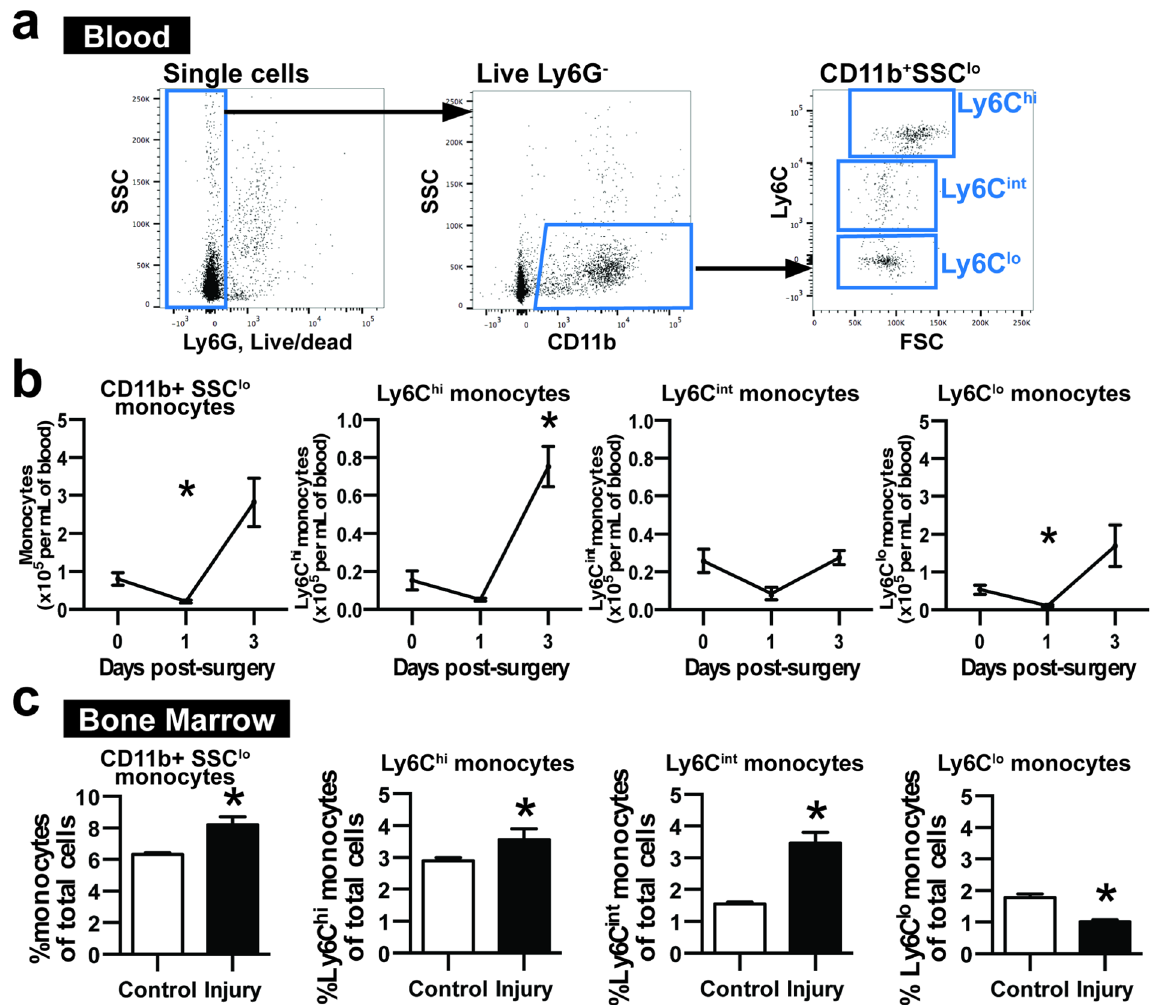
Figure 1. Wounding and biomaterial implantation induces acute changes in circulating monocytes. ( a ) White blood cells were gated on CD11b + SSC lo expression and categorized as Ly6C hi , Ly6C int , and Ly6C lo monocytes based on Ly6C expression. Ly6G + , dead white blood cells were excluded from analysis. ( b ) CD11b + SSC lo monocytes and Ly6C hi , Ly6C int , and Ly6C lo monocytes per milliliter of blood 1 and 3 days post-injury. * p < 0.05 relative to Day 0 blood, n = 5 animals per group. ( c ) Frequency of CD11b + SSC lo monocytes and Ly6C hi , Ly6C int , and Ly6C lo monocytes within bone marrow 3 days post-injury. * p < 0.05, n = 4–10 animals per group. Data presented as mean ± S.E.M. Statistical analyses performed using either two-way ANOVA with multiple comparisons or two-tailed